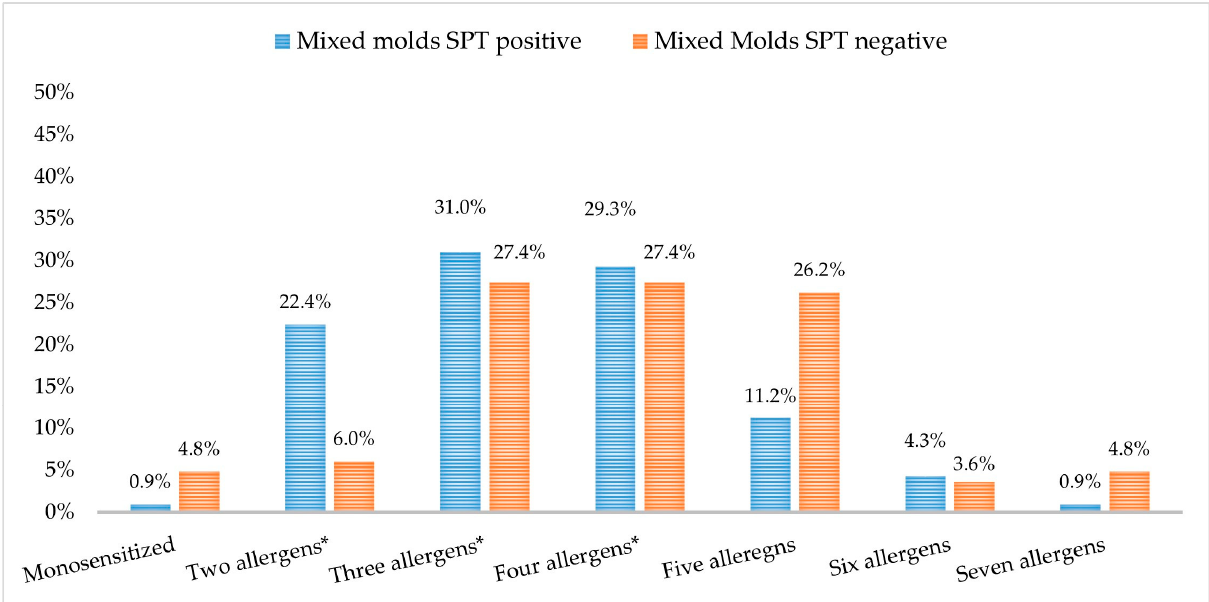
Figure 2. Polysensitization patterns in the studied patients by skin prick test (SPT). Data were ana ‐ lyzed by Fisher exact test, and significant differences were defined as * p = 0.001 (N = 200).